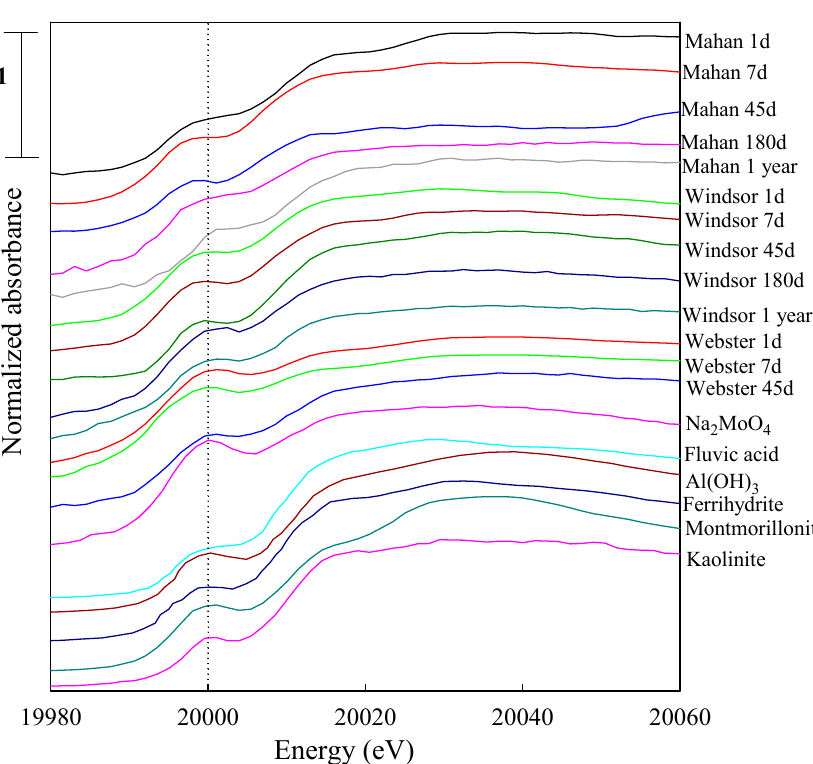
Figure 5. Mo K-edge XANES spectra of selected Mo reference compounds, Mo sorbed kaolinite, Mo sorbed to montmorillonite, Mo sorbed to Al(OH)3, Mo sorbed to ferrihydrite, Mo complexed to fulvic acid, and aged Mo reacted soils.